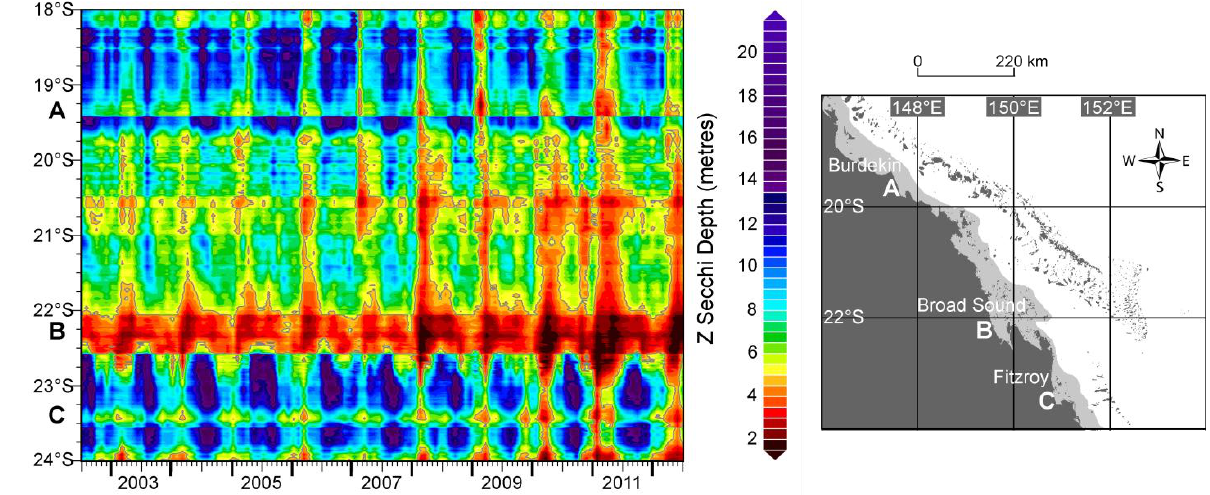
Figure 6. Hovmöller diagram illustrating the variation of water clarity on the inner shelf of the central-southern Great Barrier Reef in space (18°S–24°S) and time (July 2002–June 2012). Areas with mean Secchi depth <5 m are highlighted by grey contour. ( Right ) panel shows the bathymetry mask used to limit the spatial domain to 0–35 m, excluding reef features. The locations of (A) the Burdekin River, (B) Broad Sound, and (C) the Fitzroy River are annotated ( Left